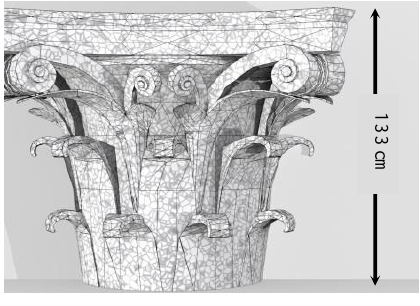
Figure 2: Synthetic image of a 3D reference model.